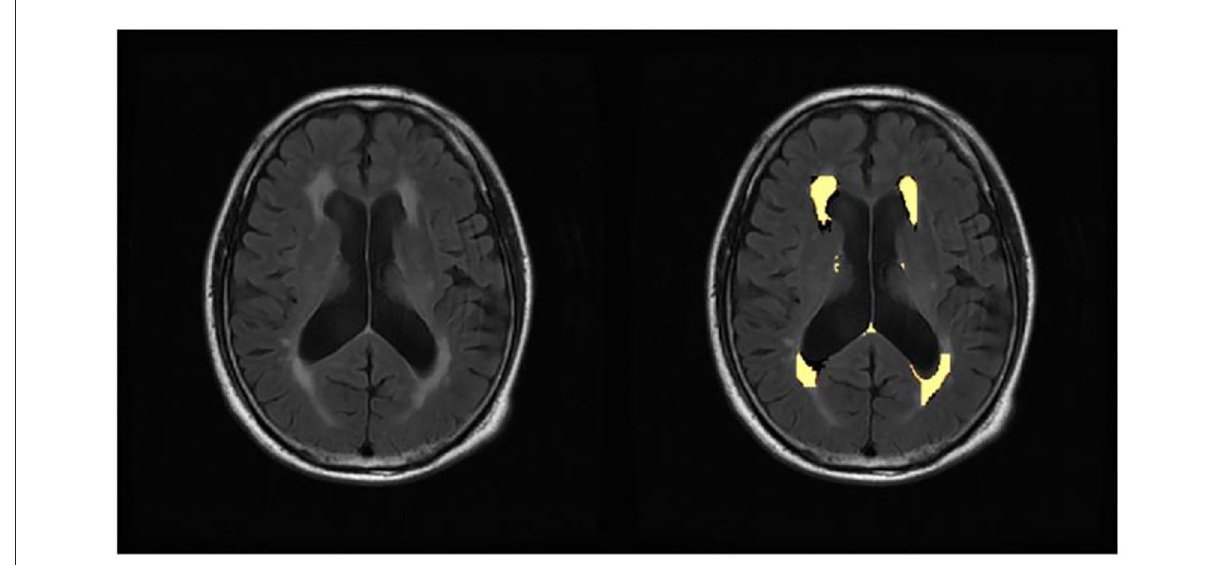
FIGURE1 Automated white matter hyperintensity segmentations on sample subject fluid-attenuated inversion recovery scan by lesion growth